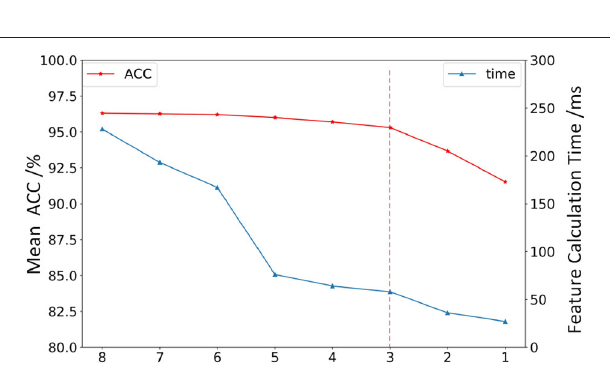
FIGURE 9 | The features calculation time and the average accuracy of the GBC model under feature reduction process. The abscissa represents the performance when the eight features are removed one by one in the order of {MC, ZC, ARC, WAV, MAX, VAR, RMS, MAC}.